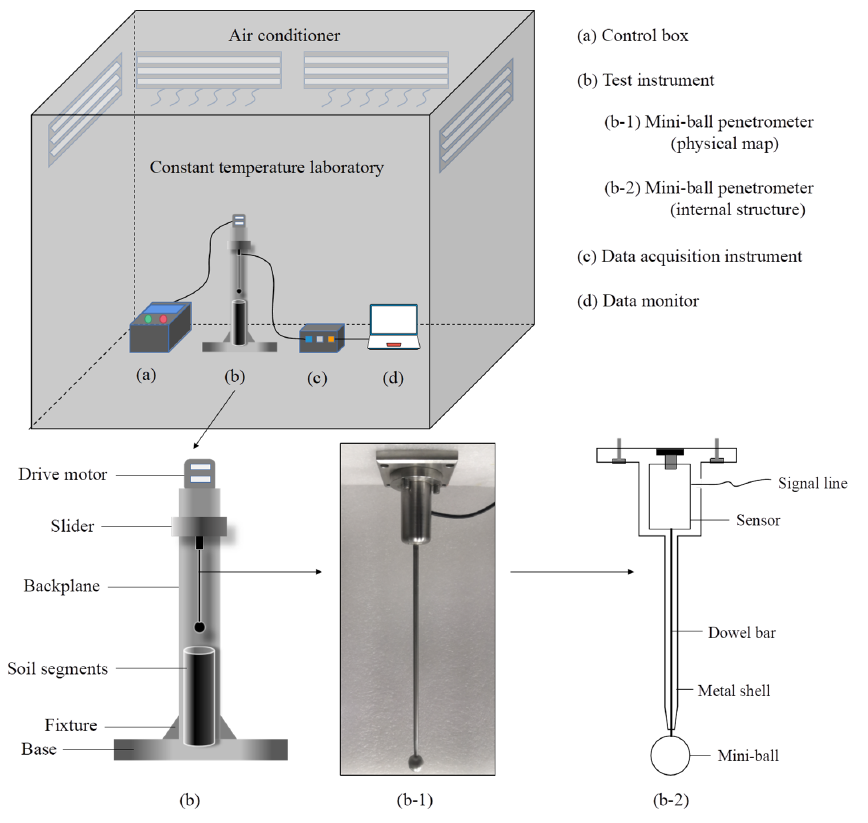
Figure 4. Mini ‐ ball penetration tests in the constant temperature laboratory: ( a ) Control box; ( b ) Test instrument; ( c ) Data acquisition instrument; ( d ) Data monitor.